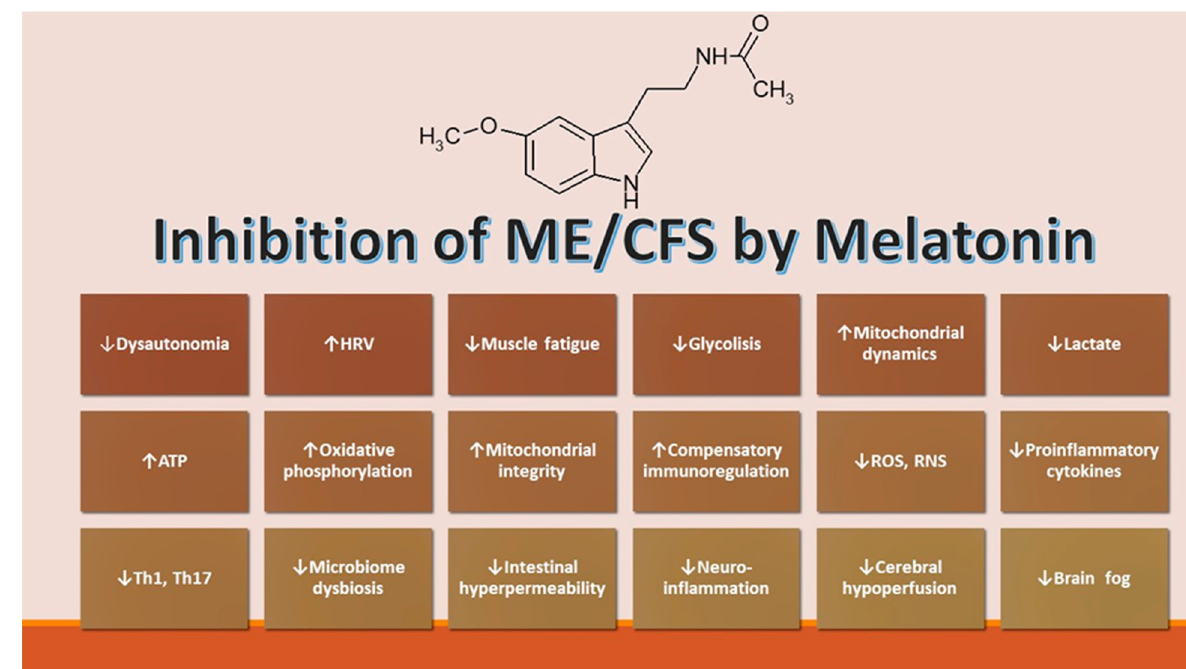
Figure 2. Putative activity of melatonin in ME/CFS. HRV: heart rate variability.